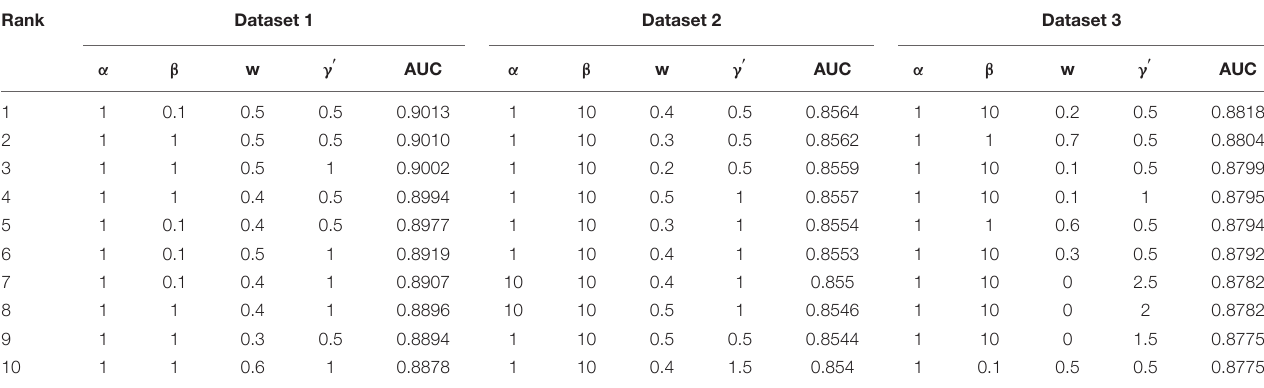
TABLE 2 | Parameter settings for the top 10 AUCs.